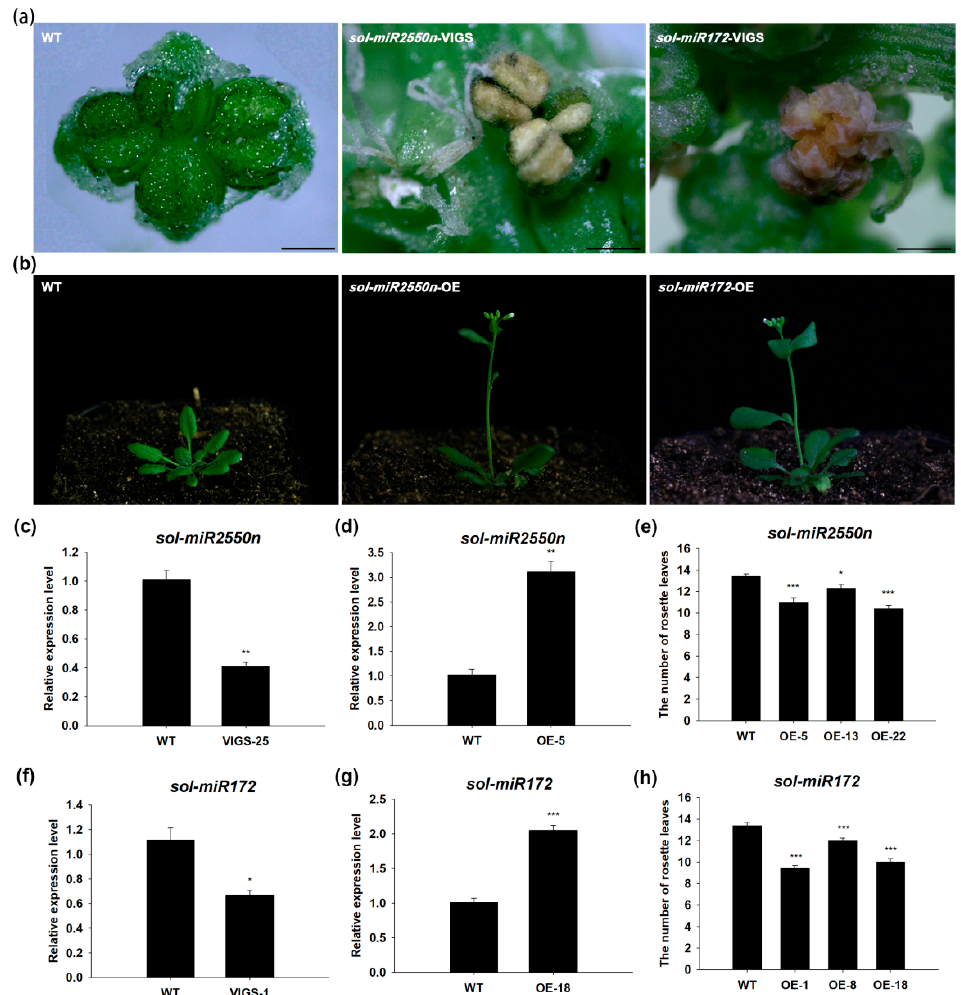
Figure 5. Phenotypes of silencing and overexpression of sol-miR2550n and sol-miR172 . ( a ) anther phenotype of wildtype (WT), sol-miR2550n- or sol-miR172 -silencing spinach male plant, scale bar = 0.5 mm; ( b ) phenotype of wildtype, sol-miR2550n- or sol-miR172 -overexpressed Arabidopsis plant; ( c ) relative expression level of sol-miR2550n in wildtype and sol-miR2550n -silencing spinach plant; ( d ) relative expression level of sol-miR2550n in wildtype and sol-miR2550n -overexpressed Arabidopsis plant; ( e ) statistics of flowering time of sol-miR2550n- overexpressed Arabidopsis plants, n ≥ 20; ( f ) relative expression level of sol-miR172 in wildtype and sol-miR172- silencingspianch plant; ( g ) relative expression level of sol-miR172 in wildtype and sol-miR172 -overexpressed Arabidopsis plant; ( h ) statistics of flowering time of sol-miR172 -overexpressed Arabidopsis plants, n ≥ 20; “*” represents p -value < 0.05; “**” represents p -value < 0.01; “***” represents p -value < 0.001; error bar represents standard error.